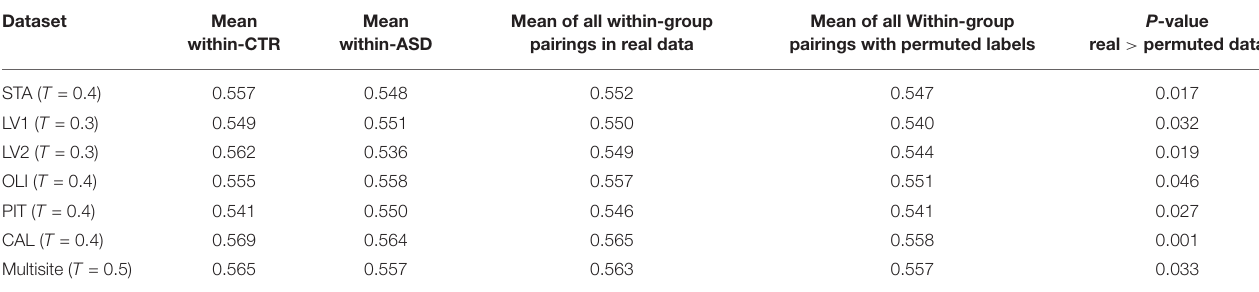
TABLE 3 | Rand index permutation testing revealed significant differences between ASD and CTR network community structures. Dataset Mean Mean Mean of all within-group within-CTR within-ASD pairings in real data